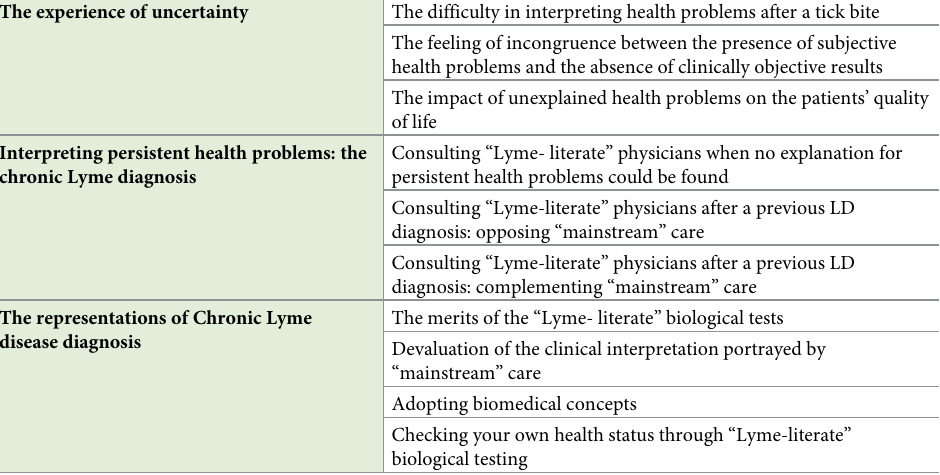
Table 2. Study’s main results. The experience of